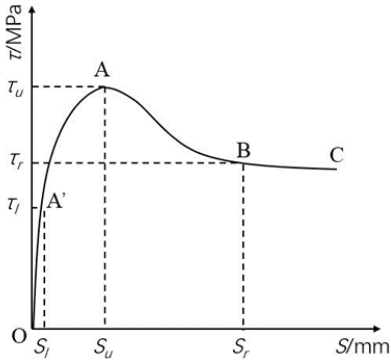
Figure 12. Complete τ -s curve and characteristic points.